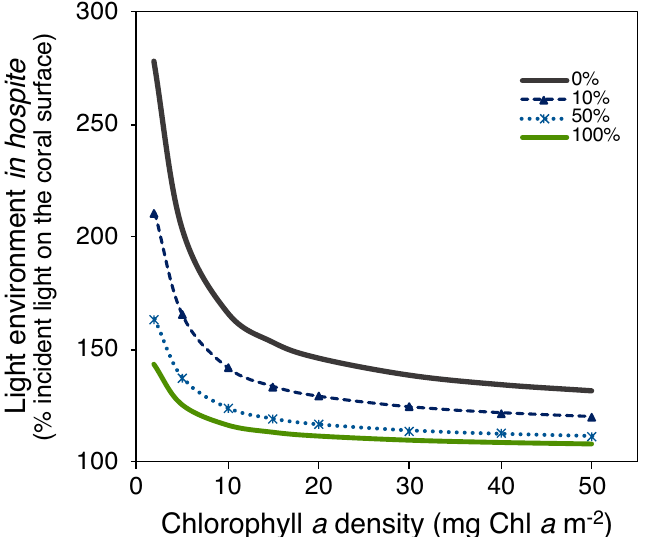
Figure 6. Variation in the light environment in hospite. The predicted variation of the light environment in hospite by the numerical model is calculated for corals at 5 m depth as: E o = (1 + 2R ) E d , where E d is the incident downwelling irradiance into the coral skeleton; and 2 is the amplification factor for a flat scattering surface. Due to the complex microstructure of coral skeletons, this amplification factor can be much larger (Enríquez et al. 2017) resulting in a larger amplification of the internal light environment. Plot ( a ) describes predicted changes in the in hospite light environment of the symbionts within intact coral fragments, as a function of changes in Chl a density and with different presence of Ostreobium spp. (abundance) on the surface of the coral skeleton: 100% (green solid line), 50% (light blue dotted line), 10% (dark blue dashed line) or when it is absent in the coral skeleton (gray solid